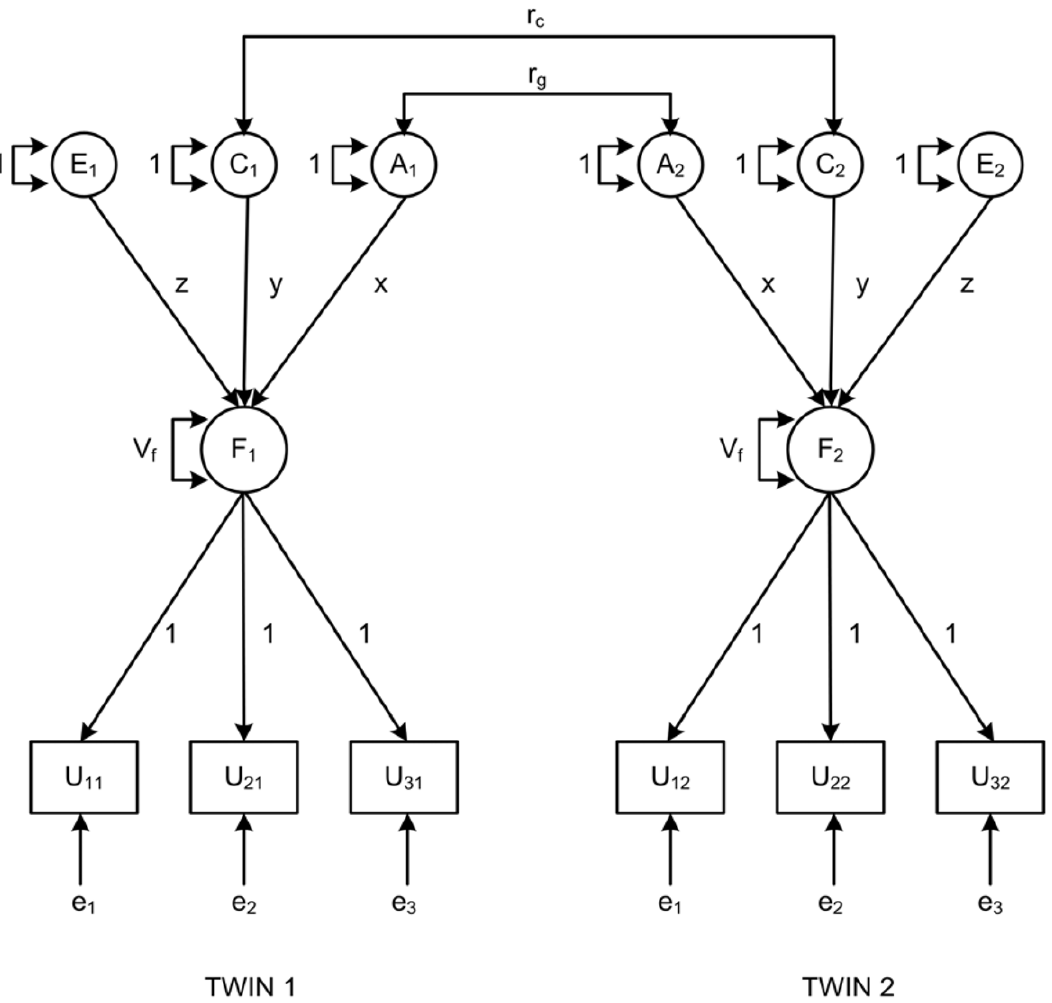
Figure 1. Structural equation model of discrete-time frailty for disability pension (DP) at three age intervals ( # 49, 50–57, and 58–64 years). Observed phenotypes, U ti , are denoted by rectangles and are the ages at which DP was granted during follow-up. t stands for age interval (t=1, 2, 3 corresponding to # 49, 50–57, and 58–64 years) and i for twin in a pair (i=1, 2). Unobserved, or latent, genetic (A), shared environmental (C), and unique environmental (E) influences are denoted by circles. Unobserved, or latent, frailty (F i ) is depicted by a circle, and is common to specific age intervals. The factor loadings of the age intervals (e t ) are set at 1. The variance in latent frailty, V f , can be divided into additive genetic (A), shared environmental (C), and unique environmental (E) variance components. Path coefficients x, y, and z stand for the standard deviations of the estimated variance components, A, C, and E, respectively. The estimates of variance components are defined as: a) heritability h 2 =x 2 /(x 2 + y 2 + z 2 + 1), b) shared environment c 2 =y 2 /(x 2 + y 2 + z 2 + 1), c) common unique environment e 2 =z 2 /(x 2 + y 2 + z 2 + 1), and d) age interval specific unique environment e 2 =1/ (x 2 + y 2 + z 2 + 1). r g denotes correlation between additive genetic effects and is set at 1 for MZ and 0.5 for DZ twins. r c is the correlation between shared environmental effects and is assumed to be equal to 1 for both MZ and DZ